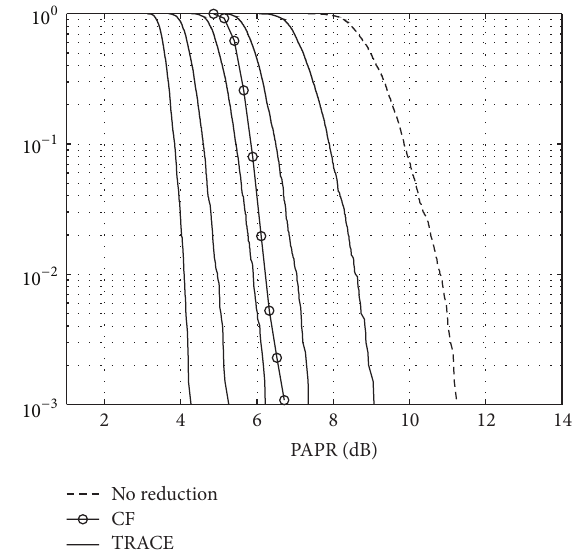
Figure 13: CCDF of the PAPR values using TRACE reduction iteratively.